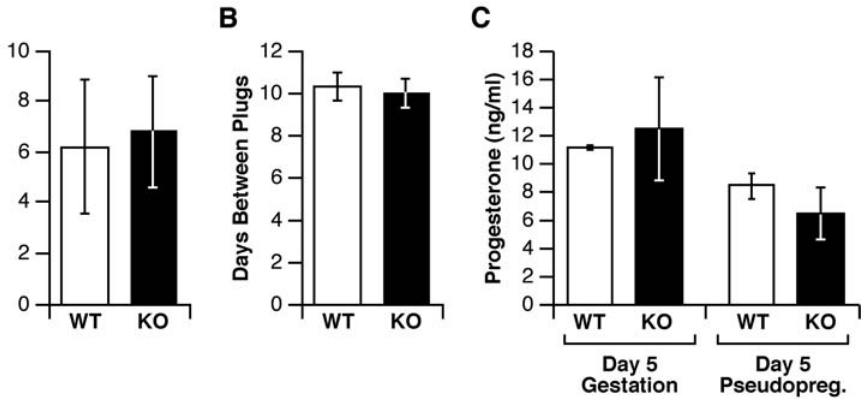
Figure 5. Cebpd-deficient females exhibit normal reproductive functions (A) Cebpd-deficient females generate normal-sized litters. Two to three-month old females with wild-type Cebpd (WT, n=10) or Cebpd null mutation (KO, n=16) were mated, the male removed subsequent to recording of a vaginal plug, and the number of pups of the following litter were counted within 24 hours after birth. (B) Cebpd -deficient females display regular estrous cycles. Two month-old Cebpd null females (KO, n=5) and wild-type littermate controls (WT, n=4) were mated to vasectomized, sterile males and monitored daily for the occurrence of vaginal plugs over a period of 40–50 days. The number of days between 19 plugs per group was averaged. (C) Cebpd -deficient females display normal progesterone levels. Progesterone levels were measured in serum from mice on day 5 of gestation (from experiment in Fig. 5A, n=5 KO, 3 WT) or on day 5 of pseudopregnancy (from experiment in Fig. 5B, n=5 KO, 4 WT). Means 6 S.E.M. are shown.